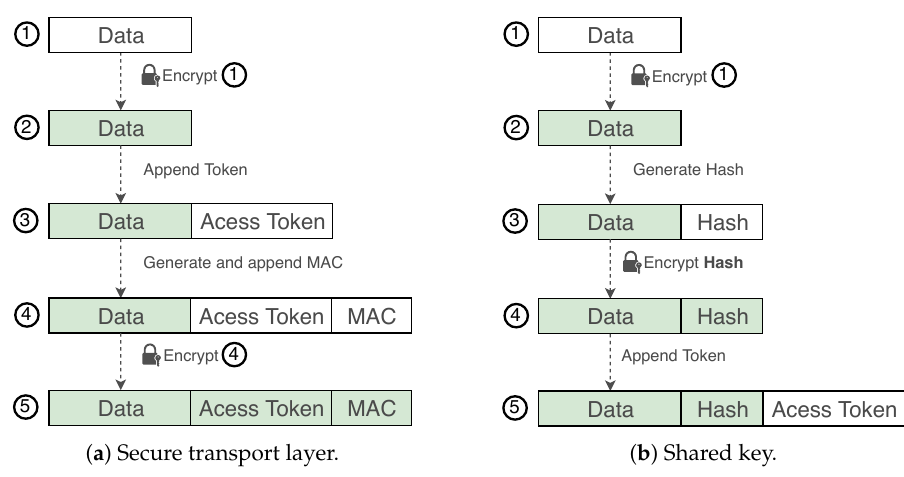
Figure 5. Cryptographic operations performed when utilizing a secure transport layer protocol ( a ) or a shared key with the cloud provider ( b ). The grey and white boxes represent encrypted and plain content,